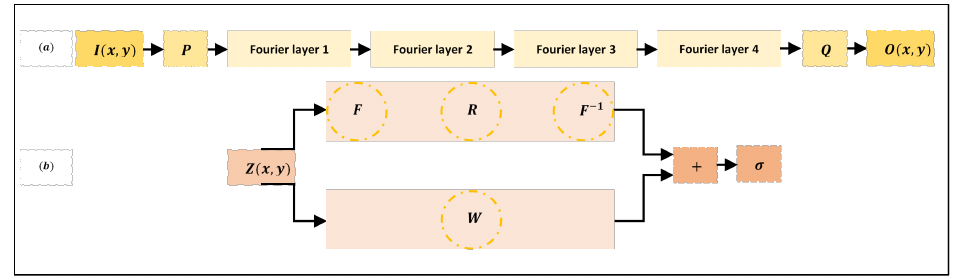
Figure 1. ( a ) Architecture of the neural operator and ( b ) Architecture of a Fourier